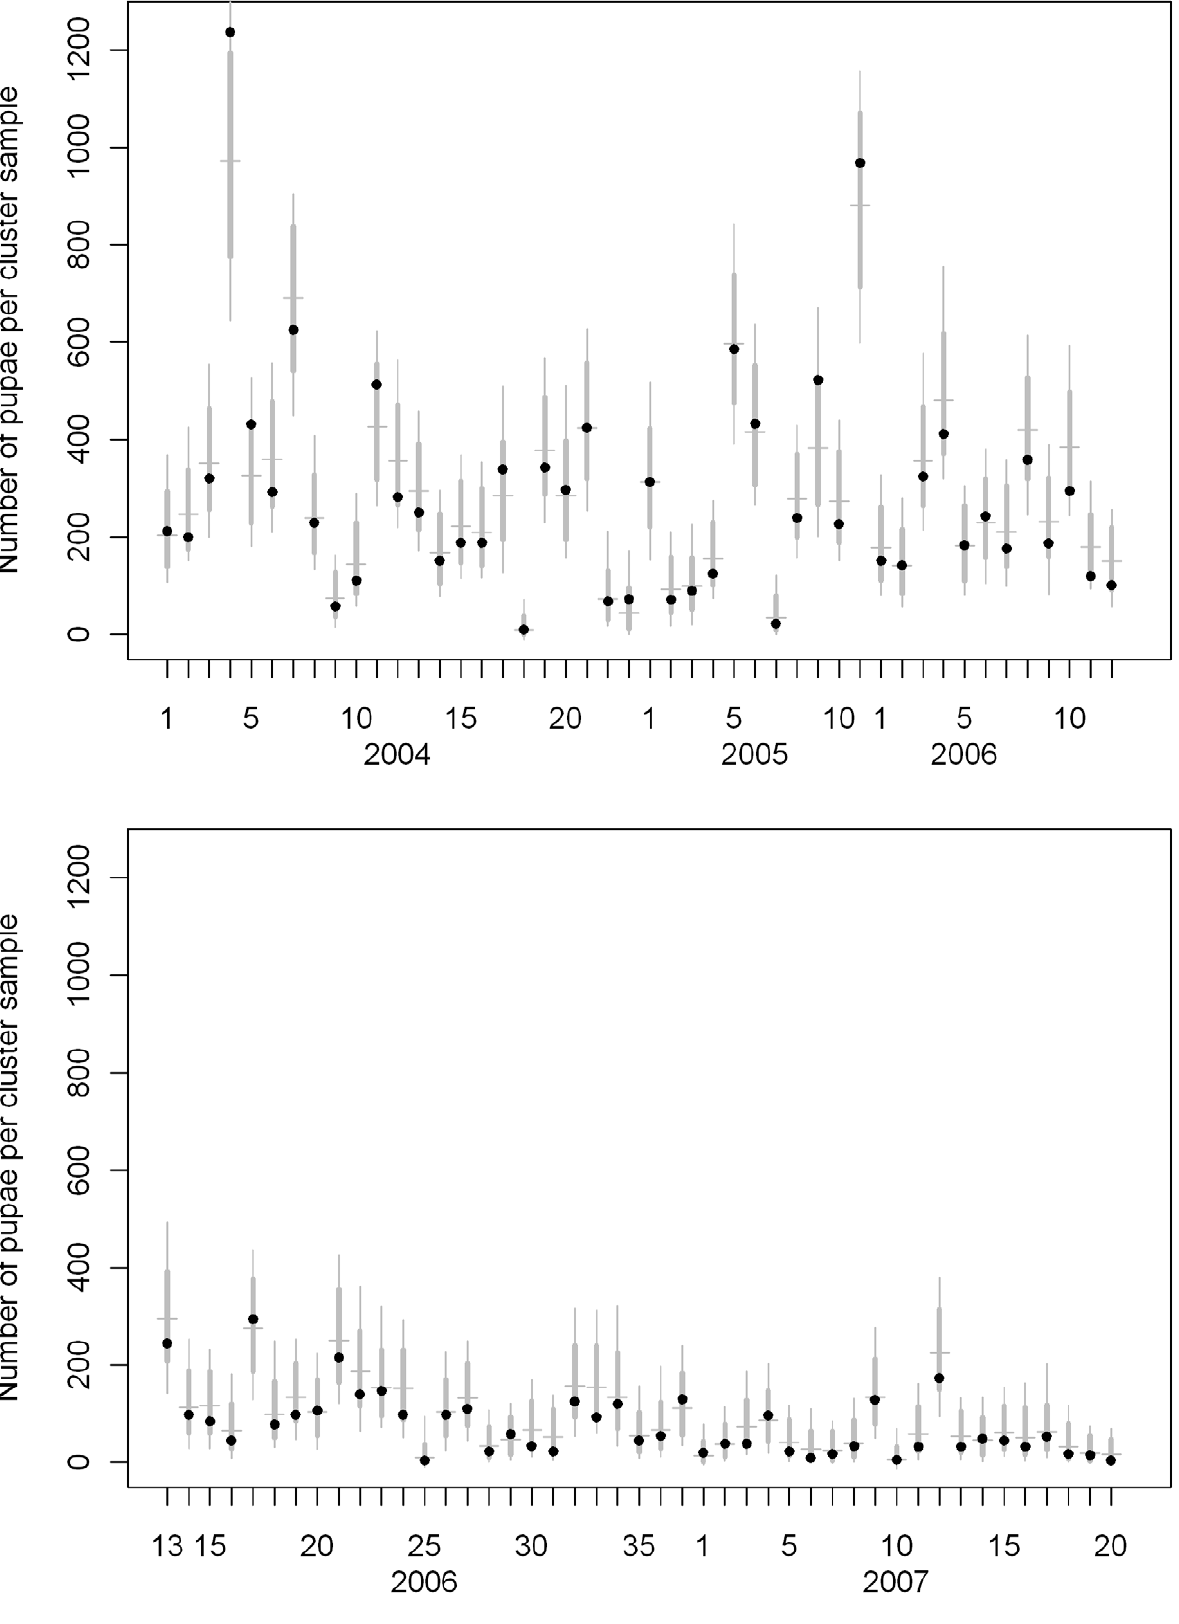
Figure 4. Cluster survey Ae.aegypti pupal population prediction. The black dots indicate the number of pupae collected during cluster surveys (2004–2007). The horizontal gray line indicates the median of 1000 simulation values. The thick gray vertical line indicates the central 95% of simulation values, and the thin gray vertical line indicates the range of all the simulations.